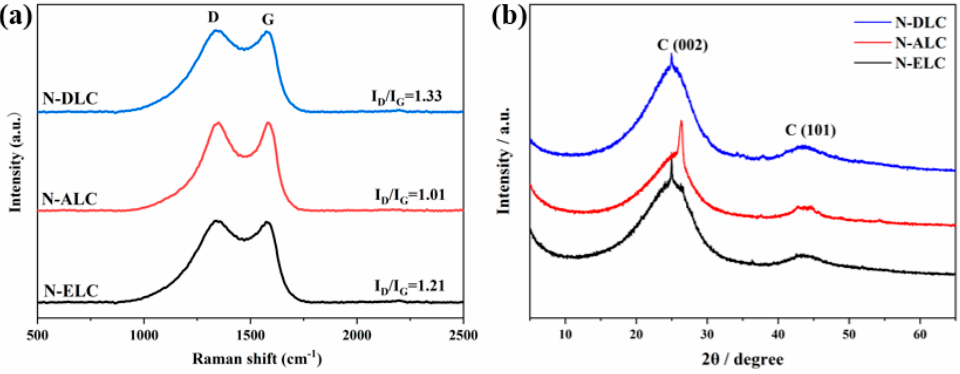
Figure 6. ( a ) Raman spectra and ( b ) XRD spectra of different kinds of lignin carbon materials.